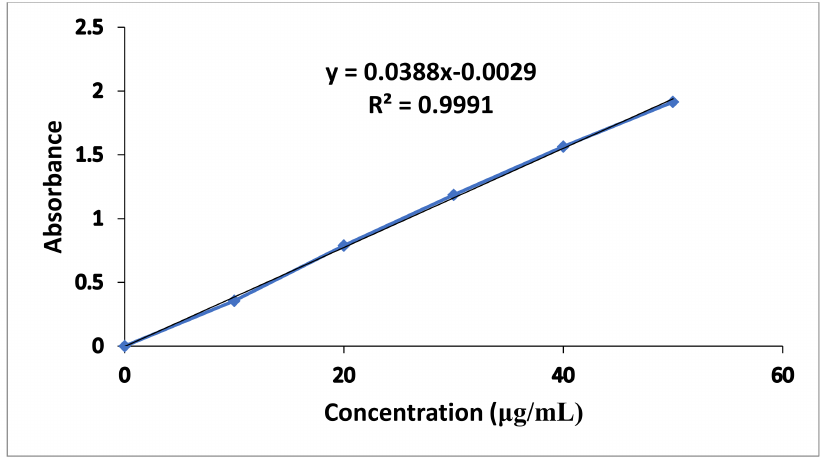
Figure 1. Metronidazole Standard Calibration Curve in 0.1 N